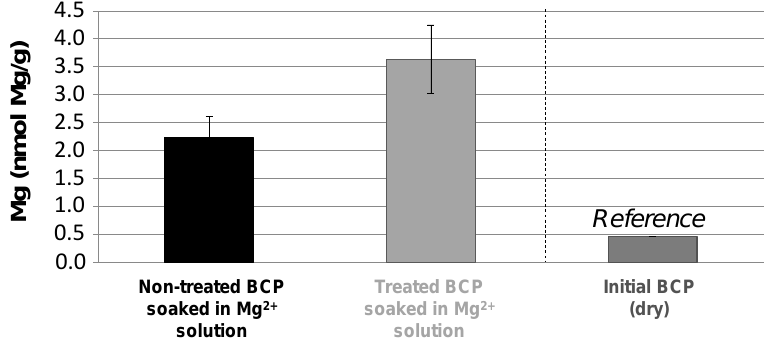
Figure 7. Average Mg 2+ ion content of sample (BCP cubes) treated or not with high pressure CO 2 (standard protocol) and after immersion in a solution of Mg 2+ ions (10 min, magnesium chloride 1M). The initial Mg content of these commercial ceramics (far right) was added for comparative purposes.